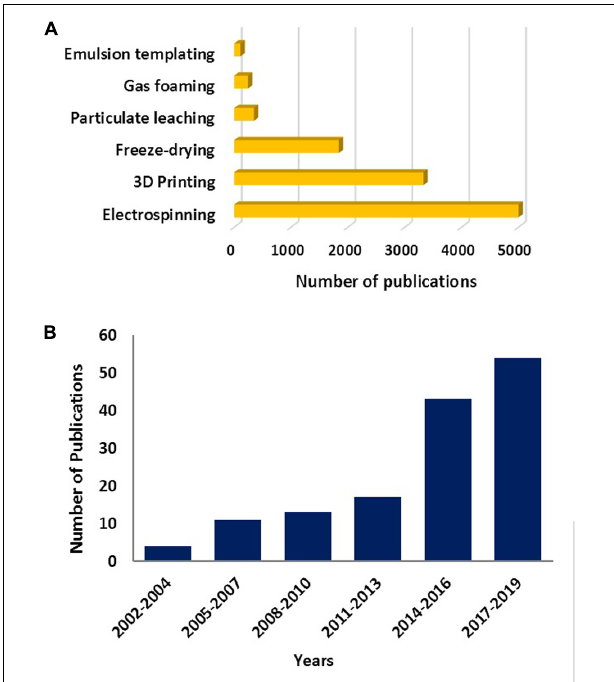
FIGURE 4 | (A) The number of publications between 1900 and 2019 (Data obtained on 22 Nov 2019) for various scaffold fabrication methods. Data generated using –the name of the manufacturing route- and “tissue engineering” as a search term. (B) The number of papers published on emulsion templating in TE in the given years. Data generated using “emulsion templating” and “tissue engineering” as search terms. Web of Science was used as a search platform, and keywords were searched in all the fields.